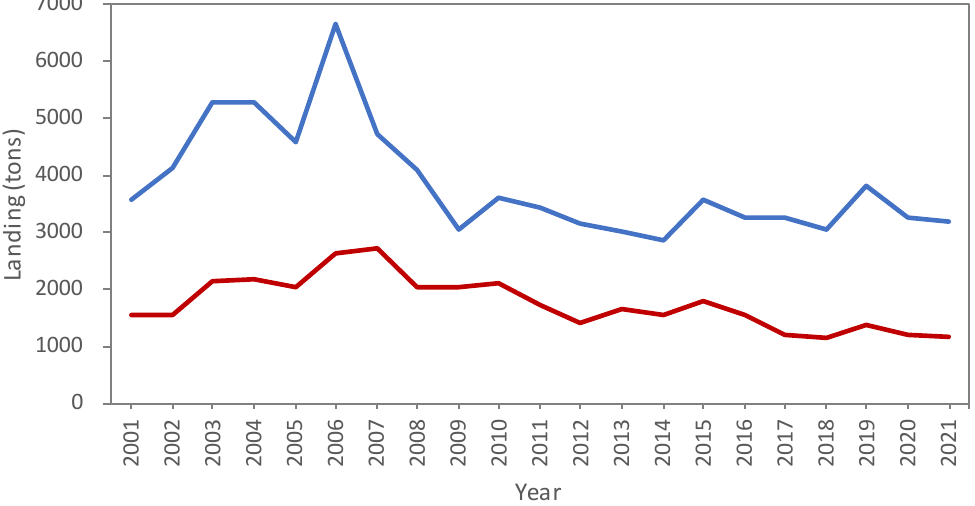
Figure 2. Annual landing at Nanfangao (blue line) and Hsinkang (red line) fishing ports from 2001 to 2021.